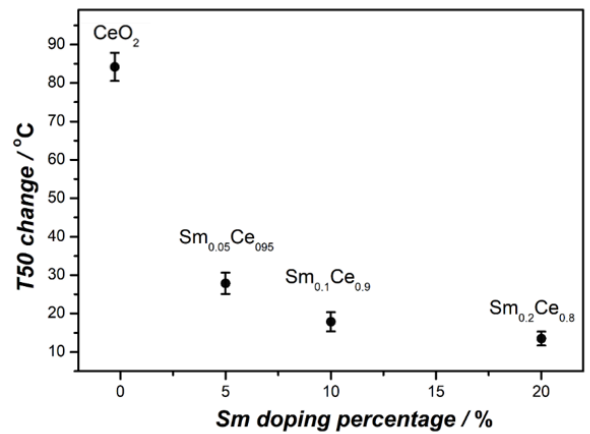
Figure 9. Relationship between T50 change (between first and seventh cycles) and Sm-doping ra- tio.